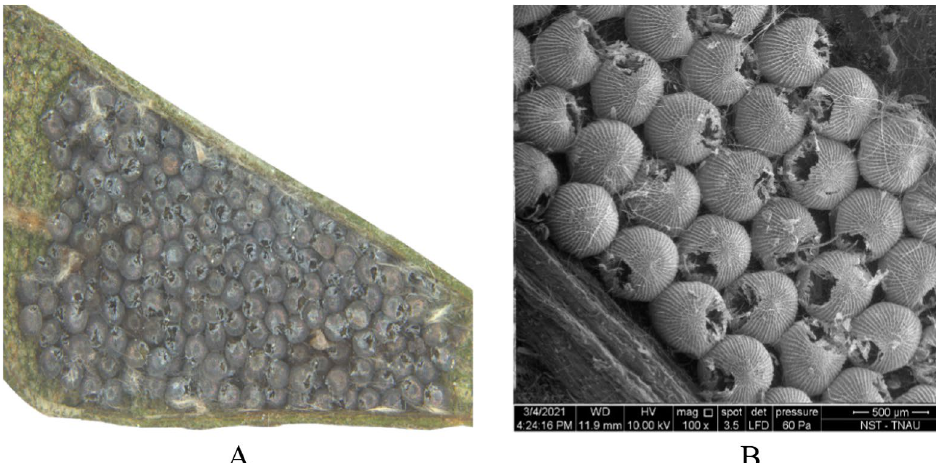
Fig. 2 A, B Parasitized egg mass of FAW showing emergence holes of T. remus